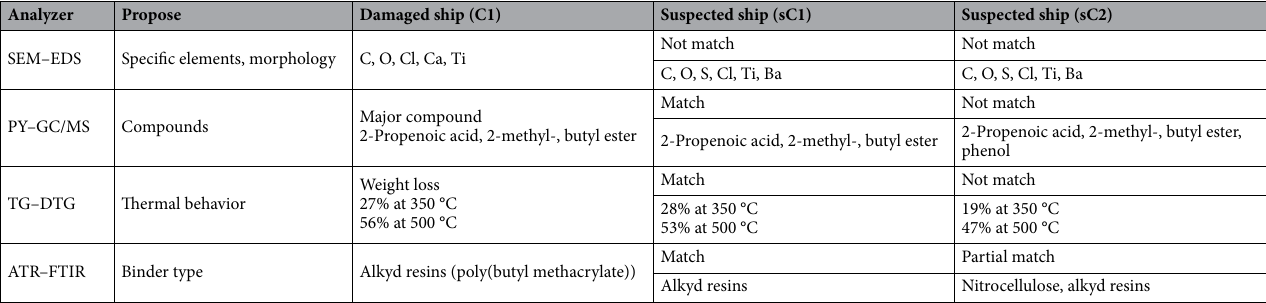
Table 2. Summary of the results of Case III